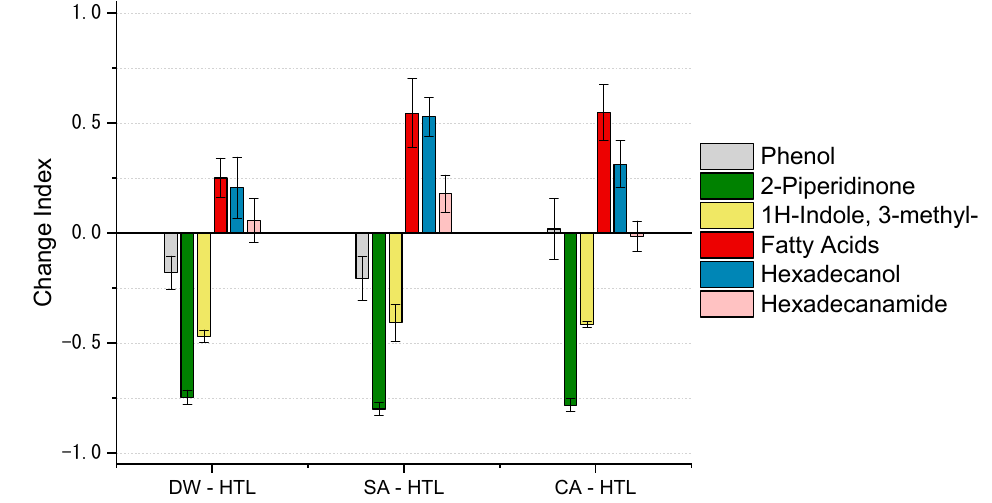
tion [75–77]. Concerning the fatty acids and their alcoholic derivates, a significant increase can be observed.